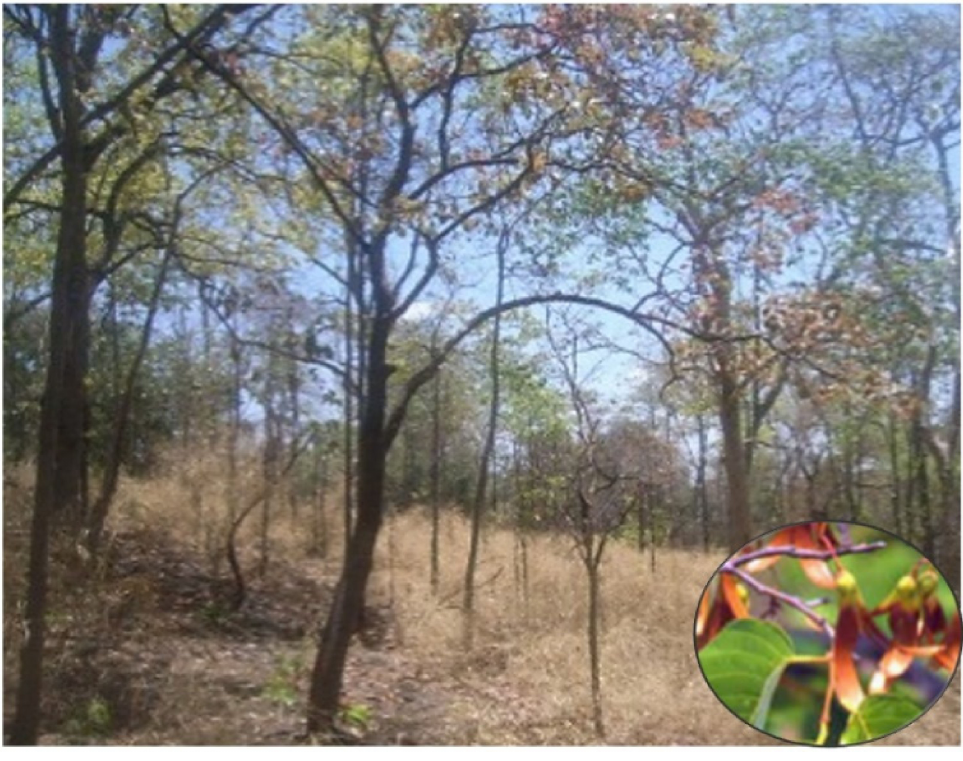
Figure A3. Shorea obtuse .